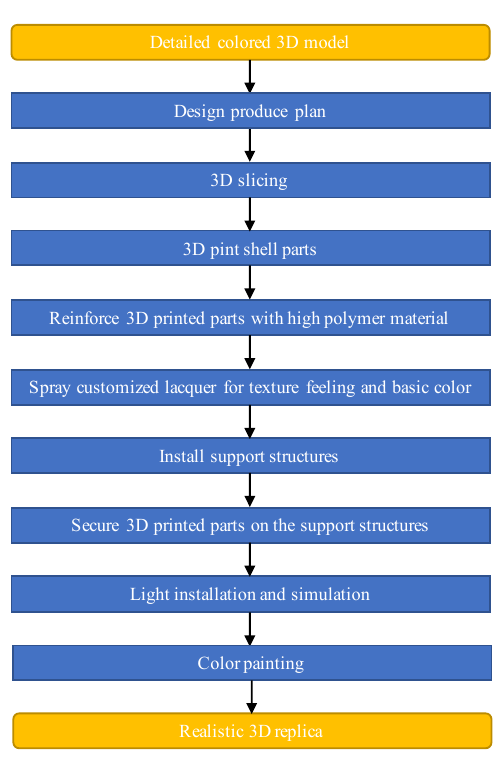
Figure 4. The 3D replicating pipeline for large